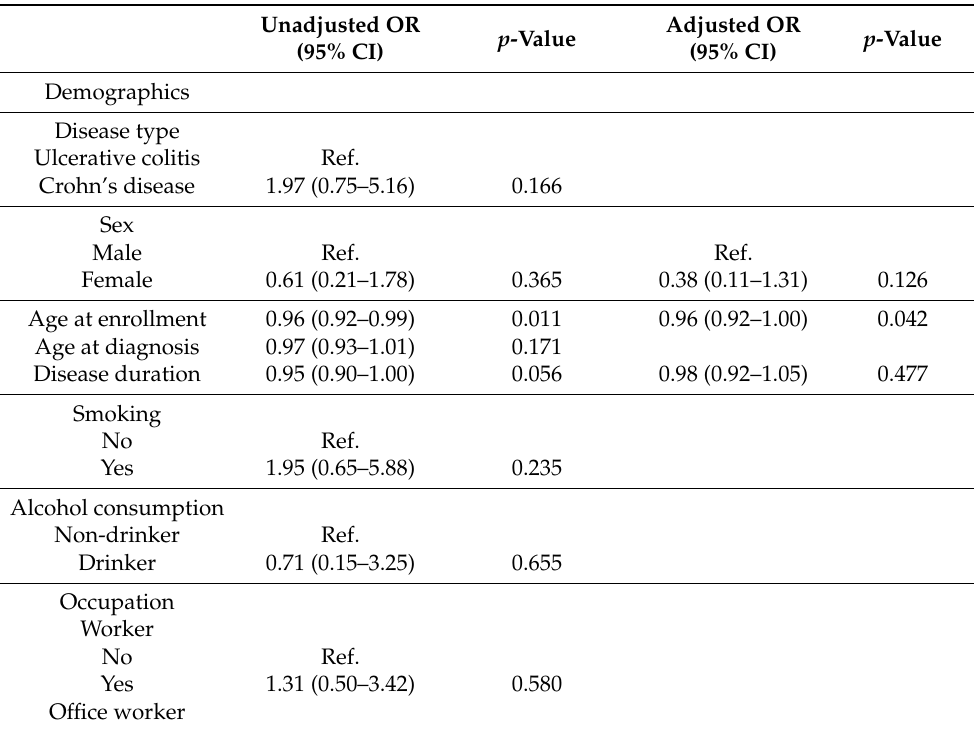
Table 2. Univariate and multivariable logistic regression analysis of hesitancy toward COVID- 19